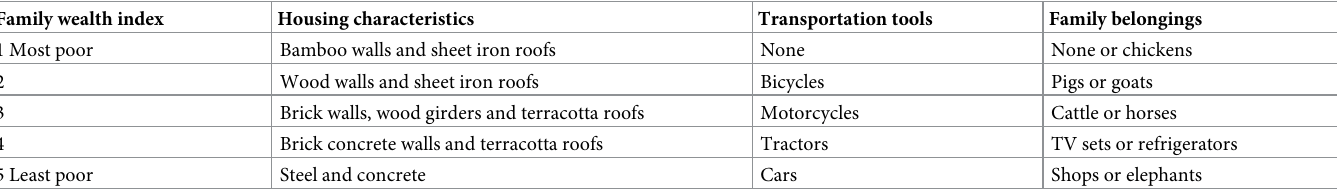
Table 1. Principal components for the construction of the family wealth index